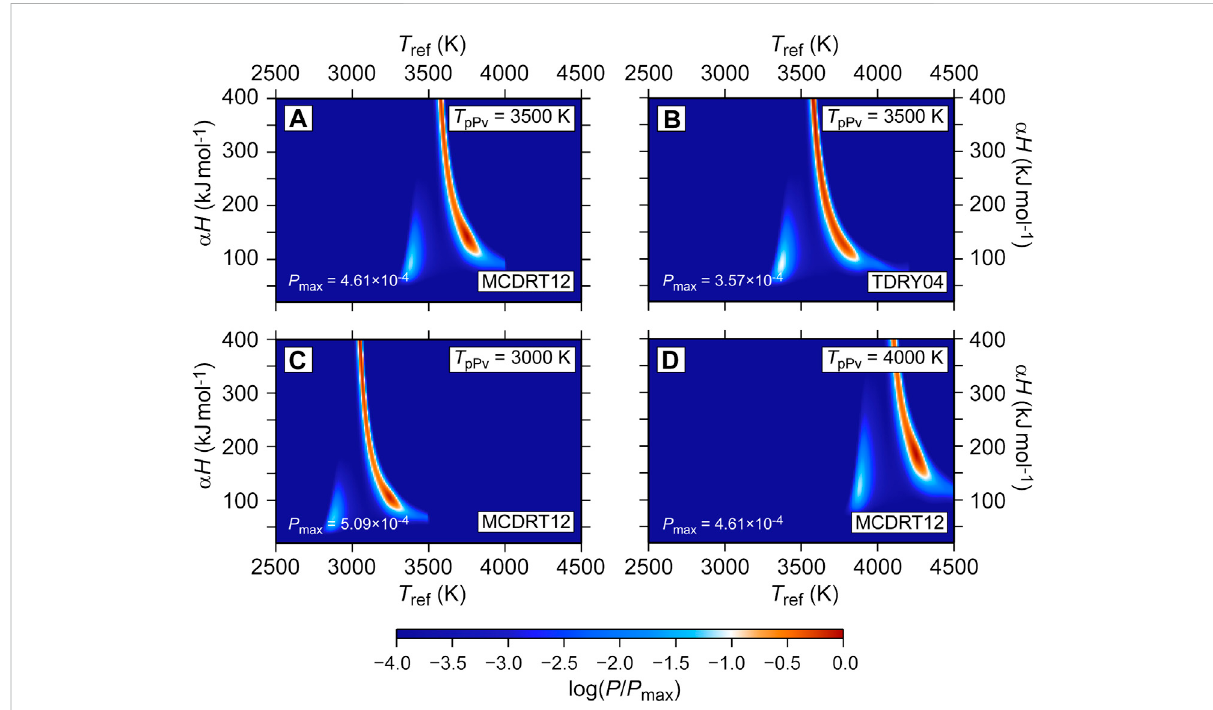
Totallikelihood( P ,colorscale),givenbyEq.9,asafunctionofthereference temperature ( x -axis)andoftheproductofthefrequencyexponent α and activation enthalpy H ( y -axis). Three values of the transition temperature to post-perovskite (pPv), T (C) ,and4000 K (D) .ThetemperaturedistributionusedtomodelthepPvaveragefractioniseitherfromMoscaetal.(2012)[plots (A,C,D) ]orTrampert etal.(2004) (B) .OthermodelingparametersarelistedinTable2.Inallcases,likelihoodsarenormalizedwiththeirmaximumvalue P max overthe range of explored T ref and α H , and plotted with logarithmic